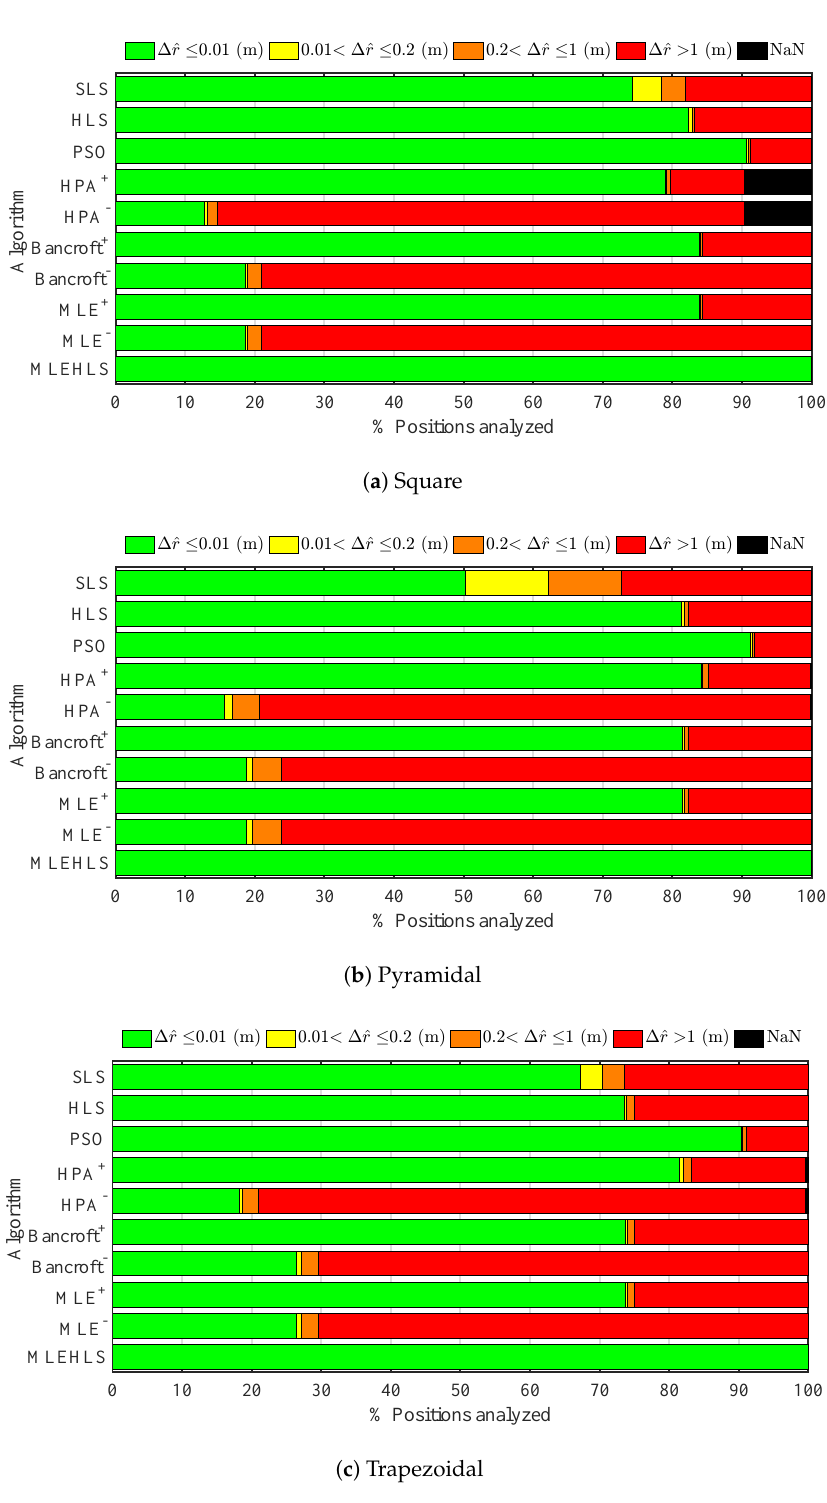
Figure 4. Percentage of positions located within the errors in the radius ∆ ˆ r defined in the legend under theoretical conditions for each algorithm and antenna array